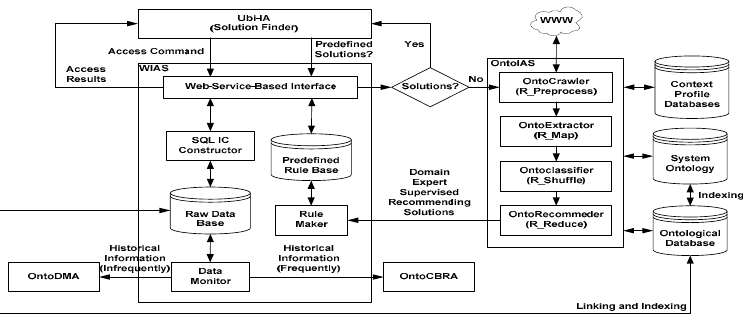
Figure 6. Framework of the WIAS System.